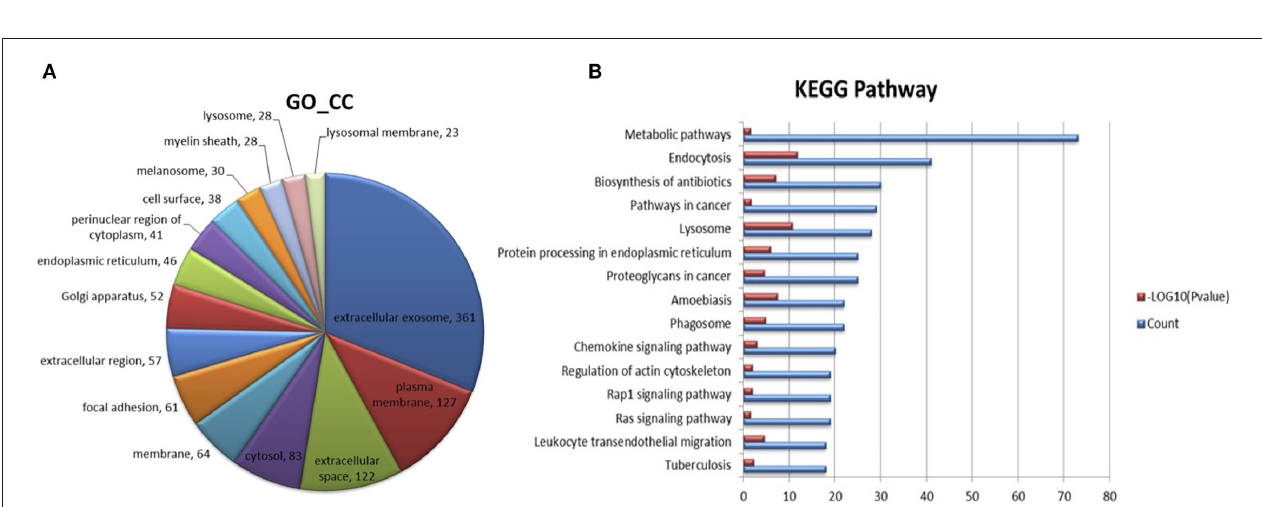
FIGURE 4 | Cisplatin-resistant ovarian cancer A2780CP cells internalize pkh26 labeled milk-exosome/cis. (A) The presence of milk-exosome/cis in A2780CP cells was analyzed by confocal microscopy after they had been incubated with PKH26 labeled milk-exosome/cis (red). The nuclei of the A2780CP cells were stained with DAPI (blue) and their cytoskeleton with Actin-Tracker Green (green). (B) Higher magnification of the area marked by square. Scale bars are shown to the right.